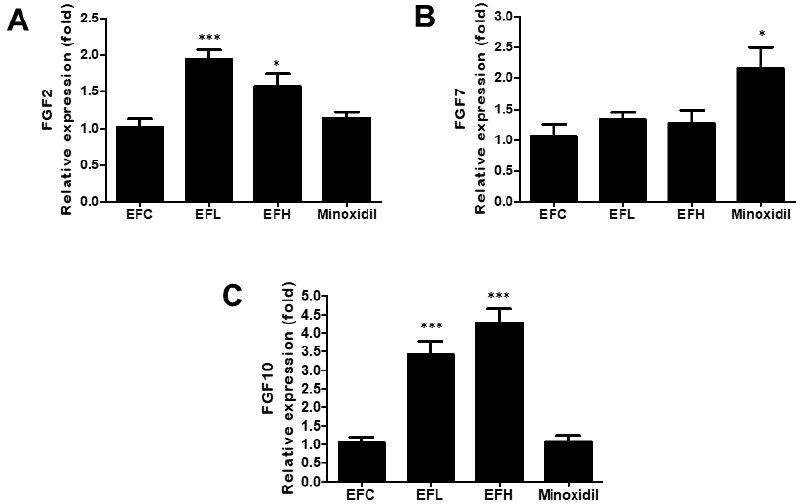
Figure 4. The effect of EF-2001 on the mRNA expression of hair-growth-related genes, ( A ) FGF2, ( B ) FGF7, and ( C ) FGF10 , in C57BL/6, male mice. Quantitative PCR analysis of the mRNA expression of FGF2, FGF7, and FGF10 in the EFC-, EFL-, EFH-, and minoxidil-treated groups. Data are expressed as mean ± SD ( n = 5). * p < 0.05, *** p < 0.001 versus EFC. 2.4. Effect of EF-2001 on the Expression of Wnt5a, Wnt5b, and Wnt10b mRNA in C57BL/6 Male Mice As shown in Figure 5, the expression of Wnt10b in the EFL- and EFH-treated groups was higher than that in the EFC-treated group, while Wnt5b expression was similar in the EFL-, EFH-, and EFC-treated groups. In the minoxidil-treated group, the expression of Wnt5a and Wnt10b increased compared with that in the EFC-treated group. The mRNA expression was 1.06 ± 0.37, 1.45 ± 0.21, 1.54 ± 0.53, and 1.82 ± 0.34 for Wnt5a , 1.01 ± 0.16, 1.16 ± 0.12, 1.01 ± 0.30, and 1.79 ± 2.24 for Wnt5b, and 1.05 ± 0.34, 2.45 ± 0.36, 2.20 ± 0.53, and 4.93 ± 0.86 for Wnt10b in the EFC-, EFL-, EFH-, and minoxidil-treated groups, respectively.